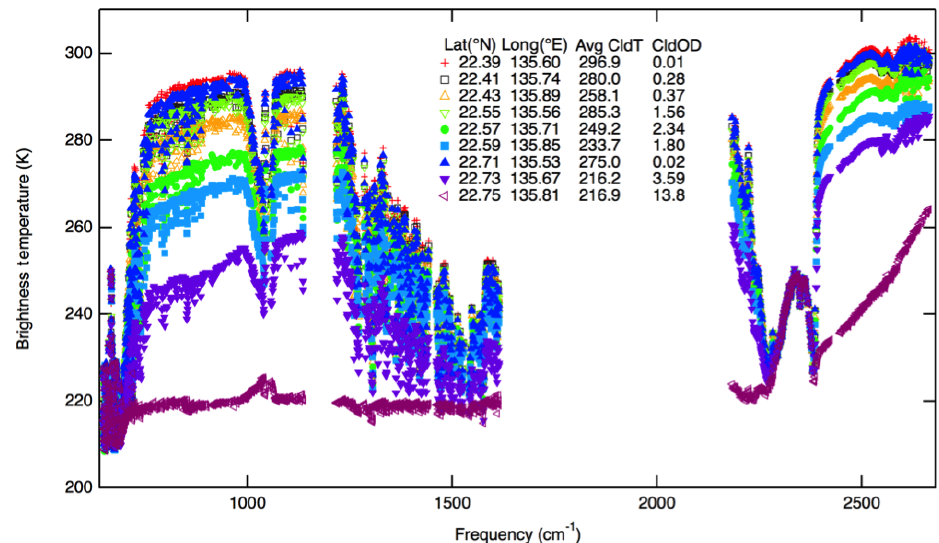
Figure 1. AIRS level 1b brightness temperature observations of adjacent cloudy spectra. Data are from daytime Granule 44, 6 September 2002. Average cloud-top temperatures and cloud optical depths are estimated from coincident MODIS L2 retrievals, averaged on the AIRS spatial response function (see Sect. 3.2.2 in